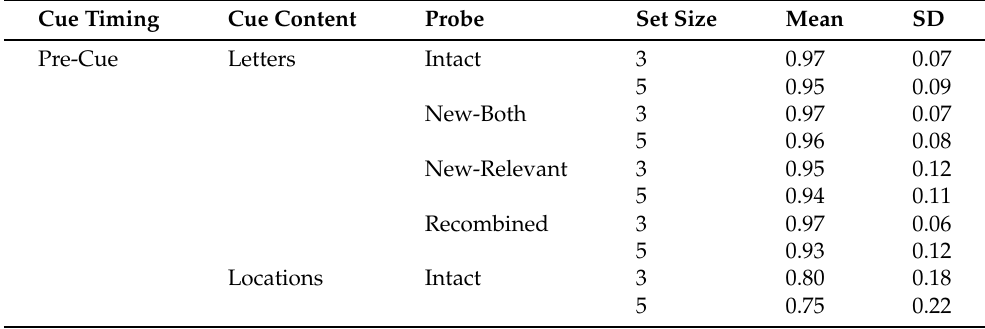
Table 1. Mean proportion correct (with standard deviations) per cue timing, cue content, probe type, and set size, Experiment